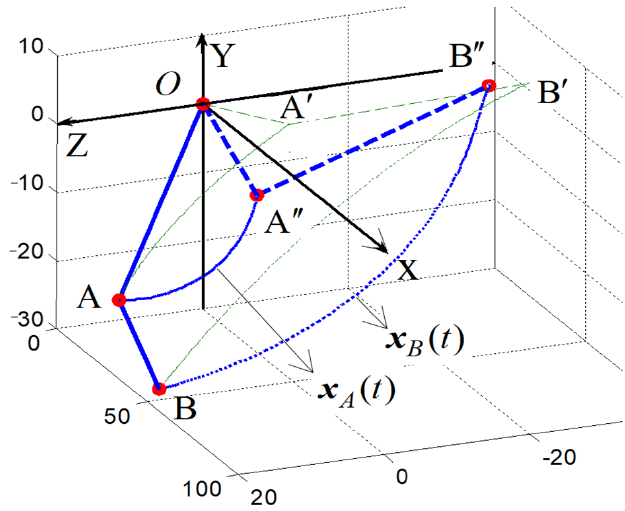
Figure 13. Comparison chart of endpoint trajectories under the controllers.